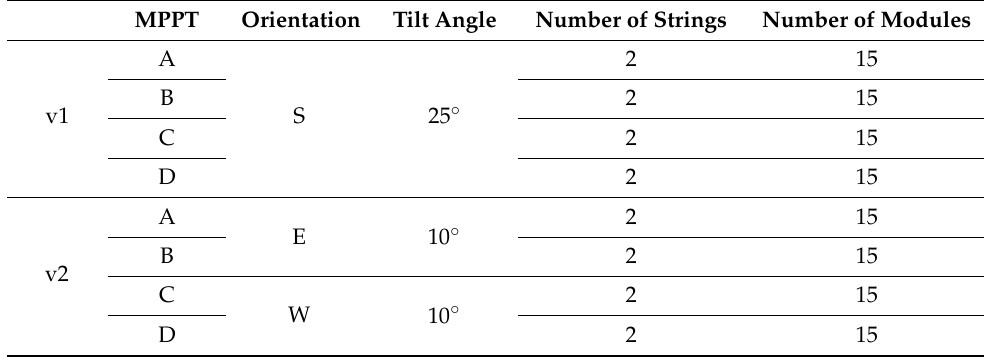
Table 2. Electrical configuration of circuits connected to the inverter in the IATC